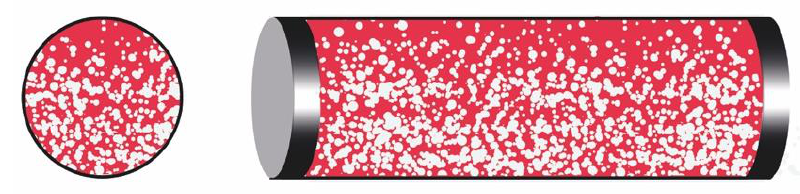
Figure A3. Oil and dispersion of water in oil. [O & Dw/o]. Dispersion of water in oil: [Dw/o]. The only flow configuration in which oil is the continuous phase across the pipe cross section is this one. Even though water is diffused in oil, it is concentrated at the bottom of the pipe in a foam-like structure similar to the one described above [17].